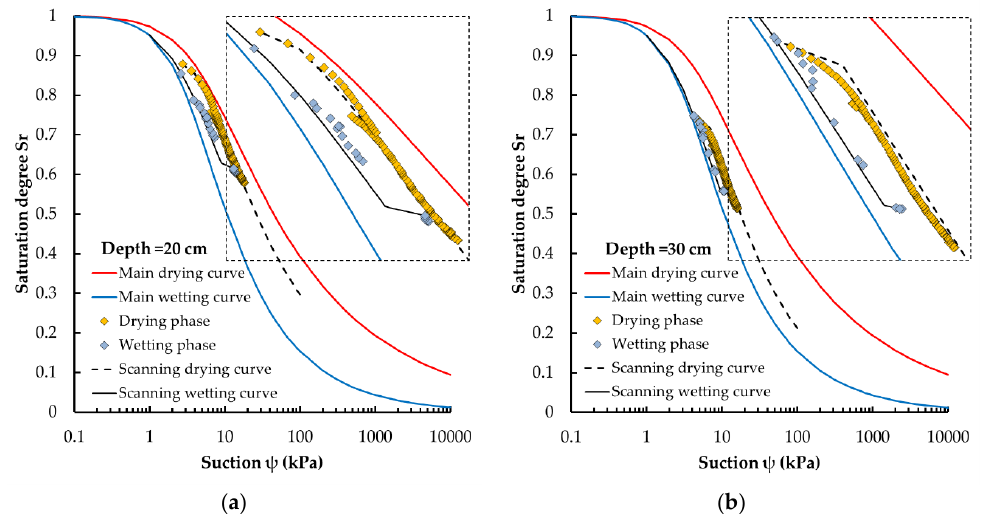
Figure 9. Comparison between scanning curves and in situ dataset. at( a ) 20 cm depth and ( b ) 30 cm depth.